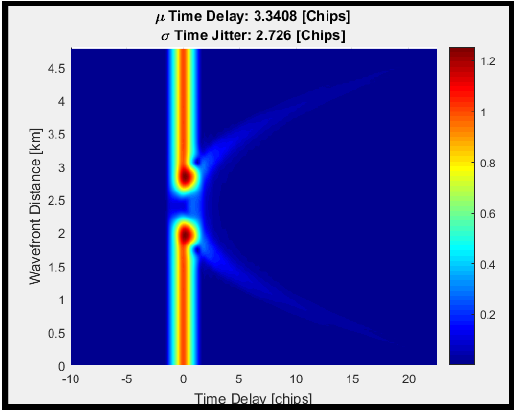
Figure 7. Global Time Delay, Analytic Solution Plot In Figure 8, the error between the analytic Global Time Delay plot and the corresponding numerical method is shown for the Gaussian lens problem. The solution from FDM is delayed by an average of approximately 0.0006 chips compared to the analytic solution. The SM algorithm does not have an average delay differential from the analytic solution. Generally, the magnitude in the overall error is smaller than in the FDM algorithm by two full orders of magnitude. The calculation of the time jitter appears to be an exact match between the SM and analytic solutions as the FDM algorithm differs by 0.0008. Potential floating point error could contribute to the inaccuracy that causes the FDM algorithm to have an artificially added delay compared to the analytic solution. It can be inferred that the floating point error accumulation grows with the propagation distance of E-field.